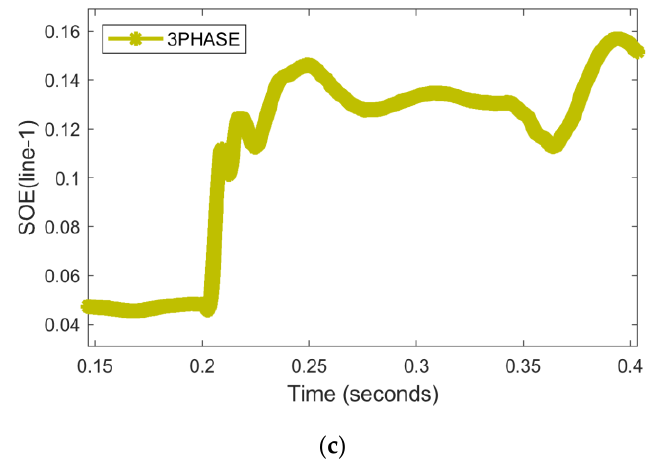
Figure 11. An LI single-phase fault hits phase A in IN mode. ( a ) Current signals ( b ) PFD ( c ) RNN- assisted SOE.